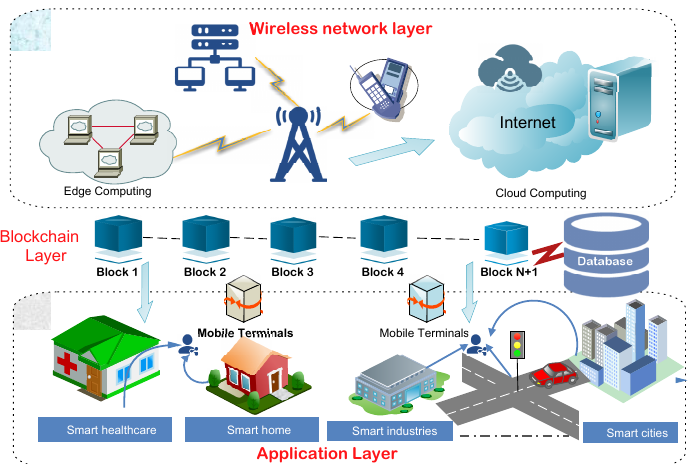
Figure 8. The proposed architecture: enabling blockchain technology for wireless